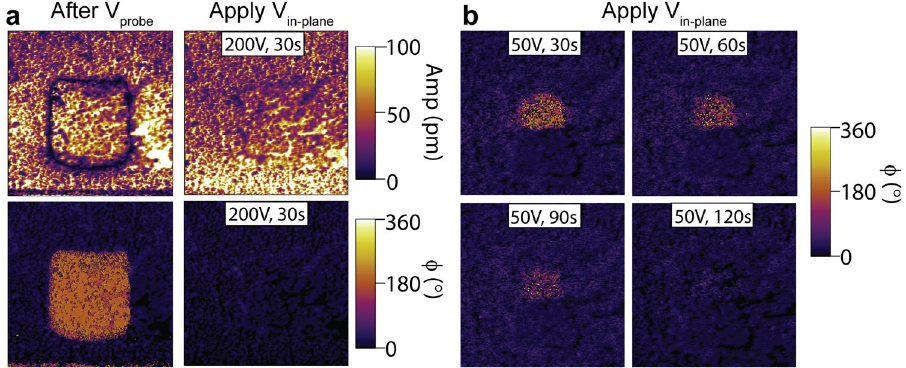
Figure 5. Restoration of up polarization by in-plane field. ( a ) PFM amplitude (top) and phase (bottom) measured right after the biased probe poling (left) and after the application of 200 V across the two surface contacts for a duration of 30 s (right). ( b ) PFM phase measured after consecutive applications of 30 s 50 V bias between the surface electrodes, showing the graduate reversion of the center 500 nm probe poled down- polarized region.